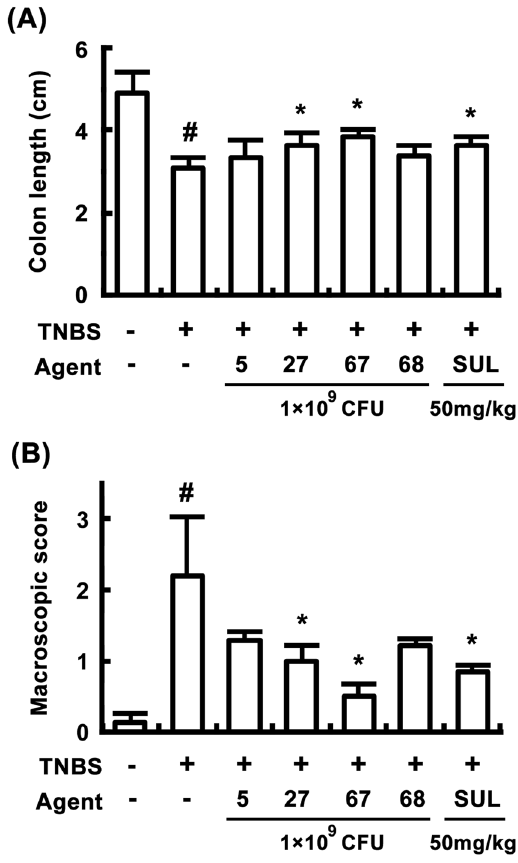
Figure 2. Anti-colitic effects of bifidobacteria and lactobacilli in mice. ( A ) Effects on colon length. ( B ) Effects on macroscopic score. TNBS, except in the normal control group, was intrarectally administered to mice and test agents [saline, LC5, LC27, LC67, LC68 (2 × 10 9 CFU/mouse), or sulfasalazine (SUL; 50 mg/kg)] were orally administered for 3 days. All data are shown as the mean ± SD (n = 6). # p < 0.05 vs. normal control group. * p < 0.05 vs. group treated with TNBS